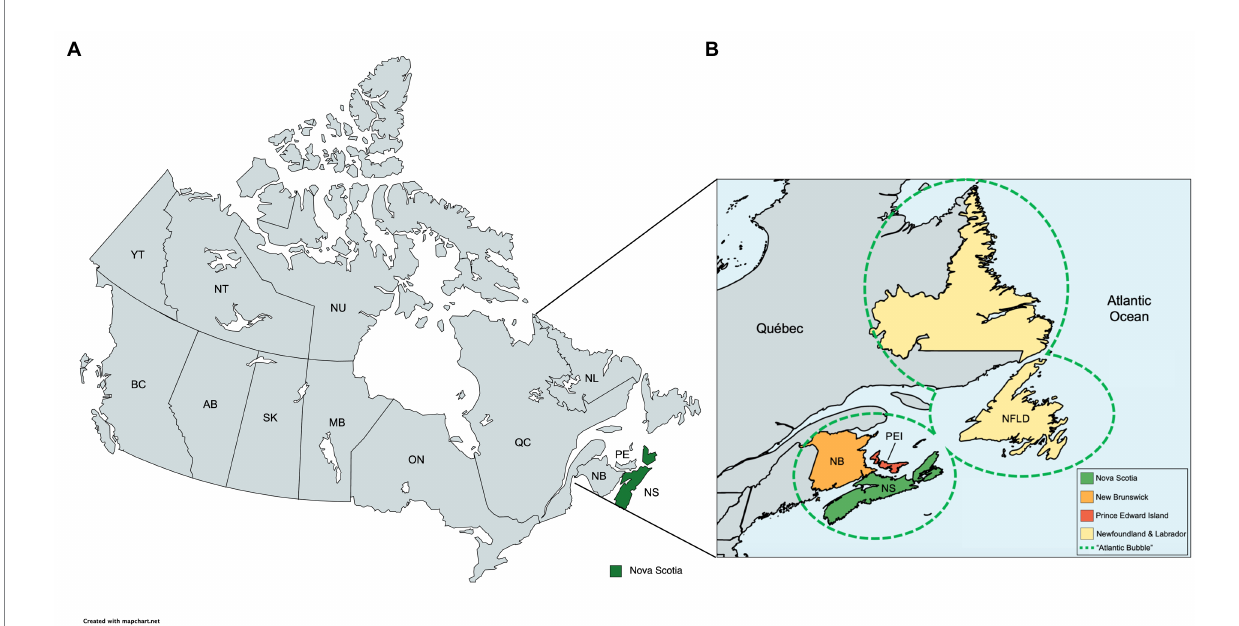
FIGURE 1 Geographical location of the Atlantic Canada. Map demonstrating the Canadian province of Nova Scotia (NS). Image created using MapChart (version 3.2.0). (A) Political geographical map of Canada with the province of Nova Scotia highlighted (green). (B) Canadian Atlantic Provinces, composed by Nova Scotia, Newfoundland and Labrador, Prince Edward Island, and New Brunswick. The dashed area represents the Atlantic